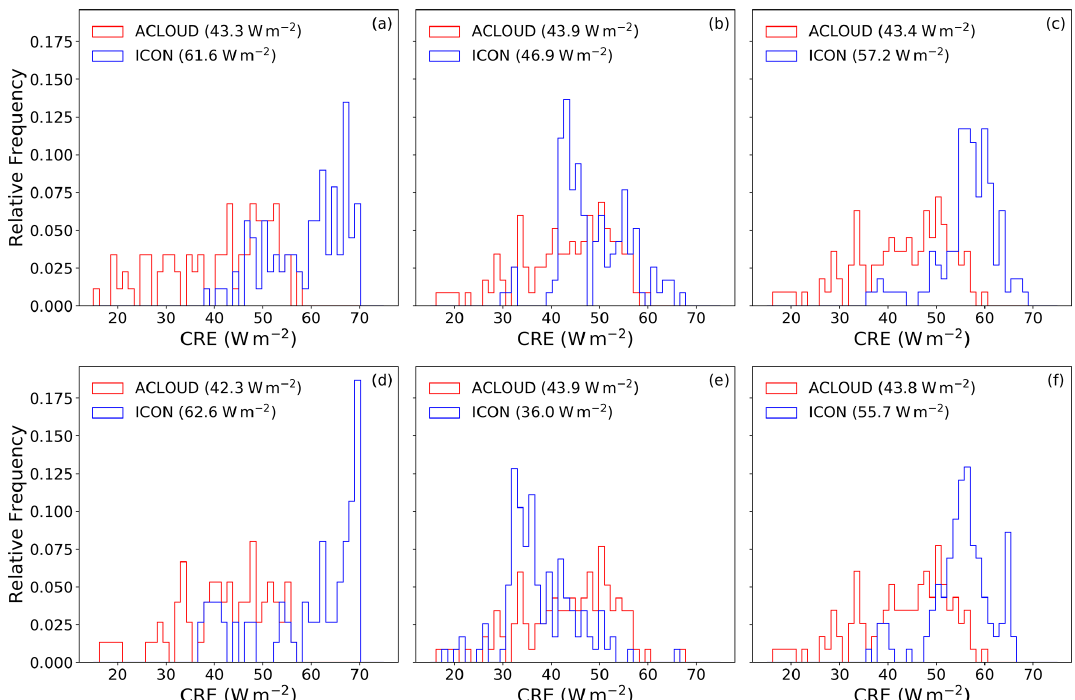
Figure 9. Same as Fig.4a but for the flights from 2 to 5 June only, for the default setup (a) , for the revised CCN activation (b) , and for the revised CCN activation with scaled number of activated CCN by a factor of 0.4 (c) . The bottom row (d–f) is the same as the top row but with hydrometeor number concentration coupled to radiation. Due to different cloud fields in the respective simulations, the histograms for the ACLOUD observations are not identical as only datapoints in the observations and the simulation are being used if both are within a cloud